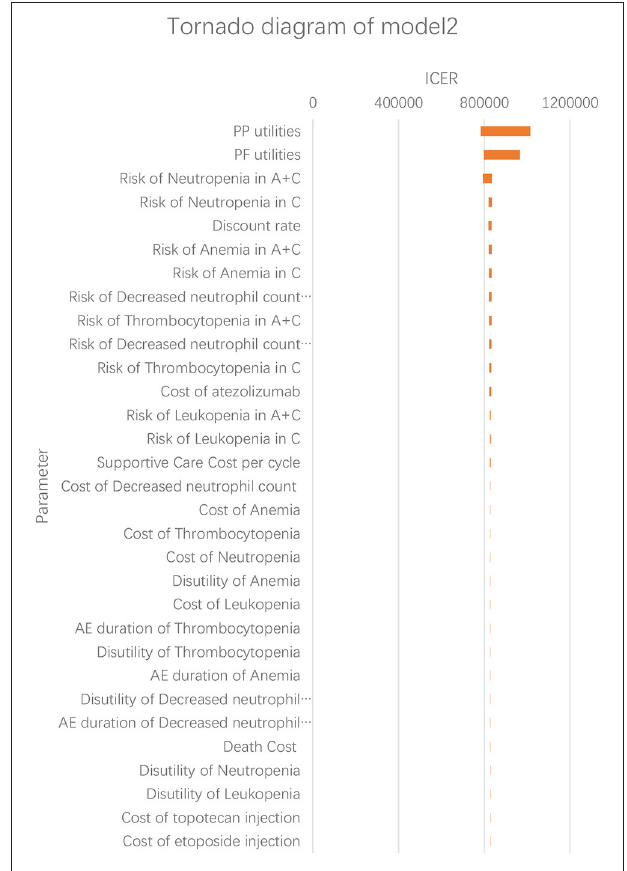
FIGURE 4 | Tornado diagram of the one-way sensitivity analysis in model 2. A + C, atezolizumab + chemotherapy; C,